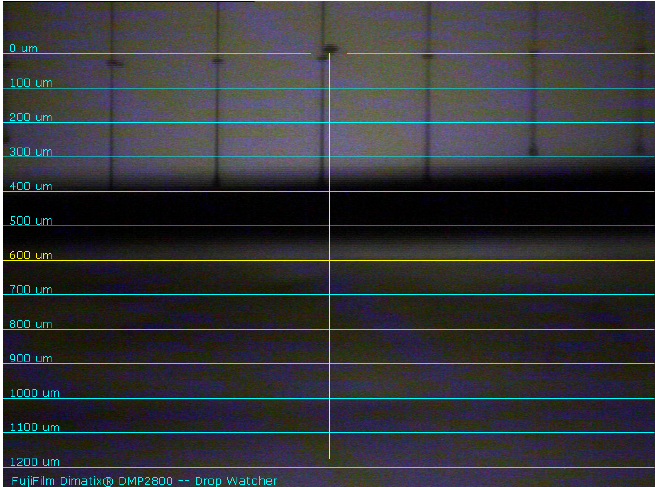
Figure 9. Jetting condition of PVA from the nozzles 5 to 10. Table 5. Summary table of characterized printed PVA. Targeted Pattern Table 6. Additional inkjet printing parameters to print PVA.